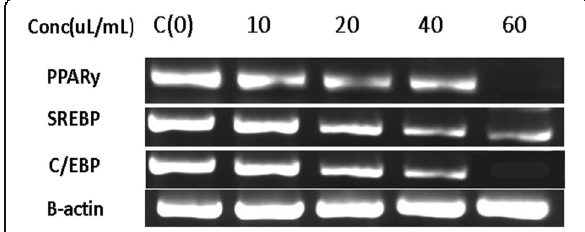
Fig. 8 Expression levels of PPARy, SREBP and C/EBP α , in the RNA extracted from 3 T3 cells treated with various concentrations of microcystins, analyzed by RT-PCR. Different concentrations of the microcystins (5 – 60 μ l/mL) were used to determine the inhibitory effects of crude microcystins on the gene expression levels of the adipogenesis promoting signaling